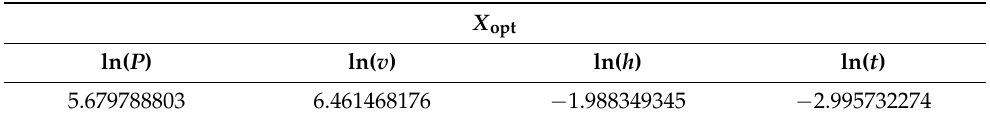
Table 8. Optimal components of vector X opt